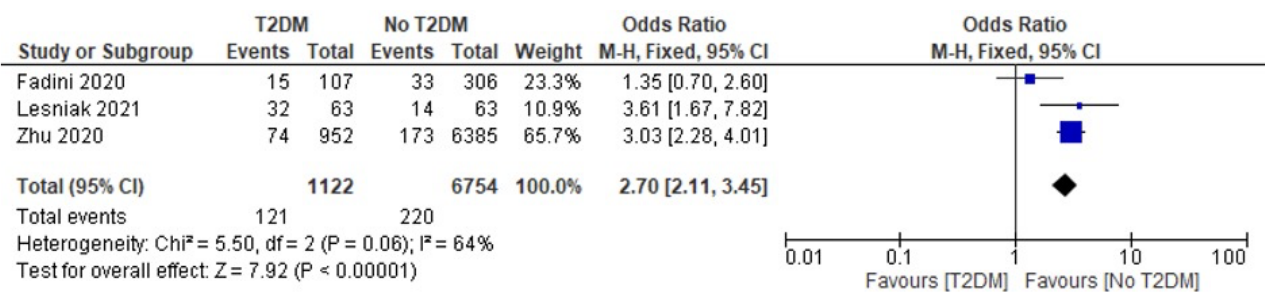
Figure 2. Forest plot for the outcome of death in the diabetic vs. non-diabetic COVID-19 patients’ comparison (calculated using a fixed effect OR of 2.70) [4,25,33].